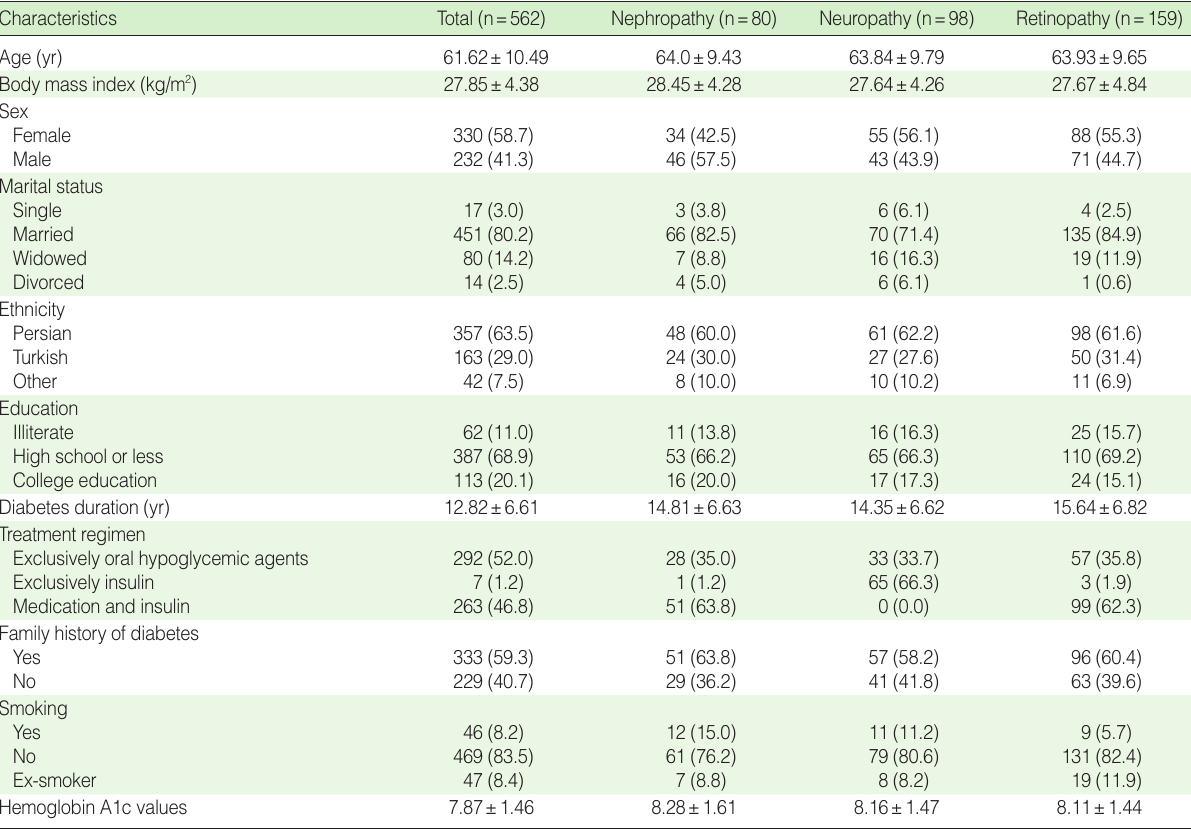
Table 1. Patient characteristics, both overall and according to the presence of the microvascular complications of diabetes